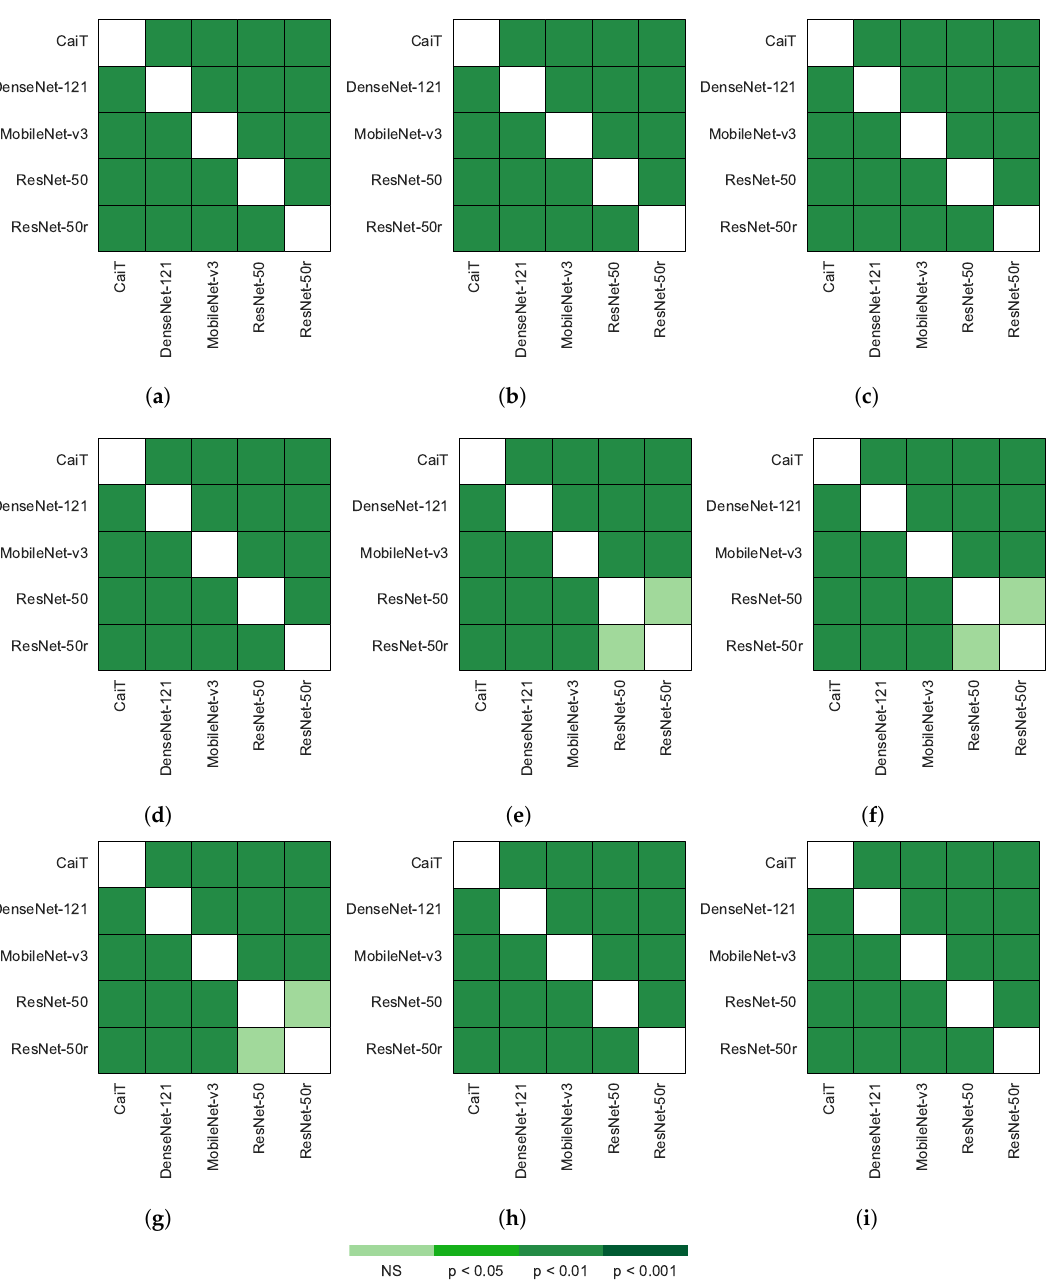
Figure 7. Nemenyi post hoc rankings pairwise of the by network for each of the performance metrics. The comparison was done for all metrics, the maximum accuracy during training and the epoch at which the maximum accuracy was reached. The comparison carried out after 1000 bootstrap cycles. ( a ) Accuracy. ( b ) Balanced accuracy, ( c ) F 1 score, ( d ) F 2 score, ( e ) Matthew’s correlation coefficient. ( f ) Sensitivity. ( g ) Specificity. ( h ) Maximum validation accuracy. ( i ) Number of epochs required to reach the maximum validation accuracy. NS stands for no significant